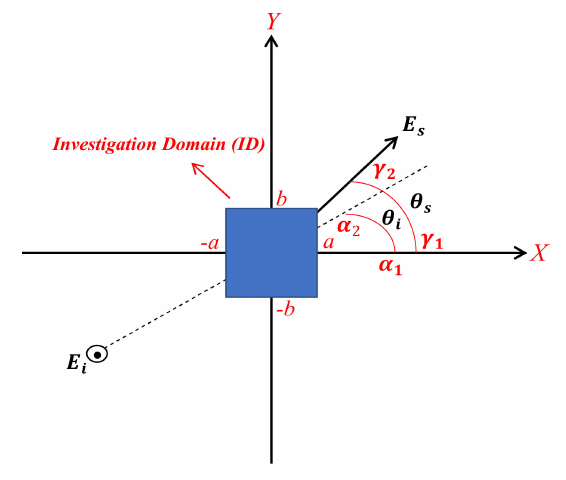
Figure 1. The geometry of a 2D